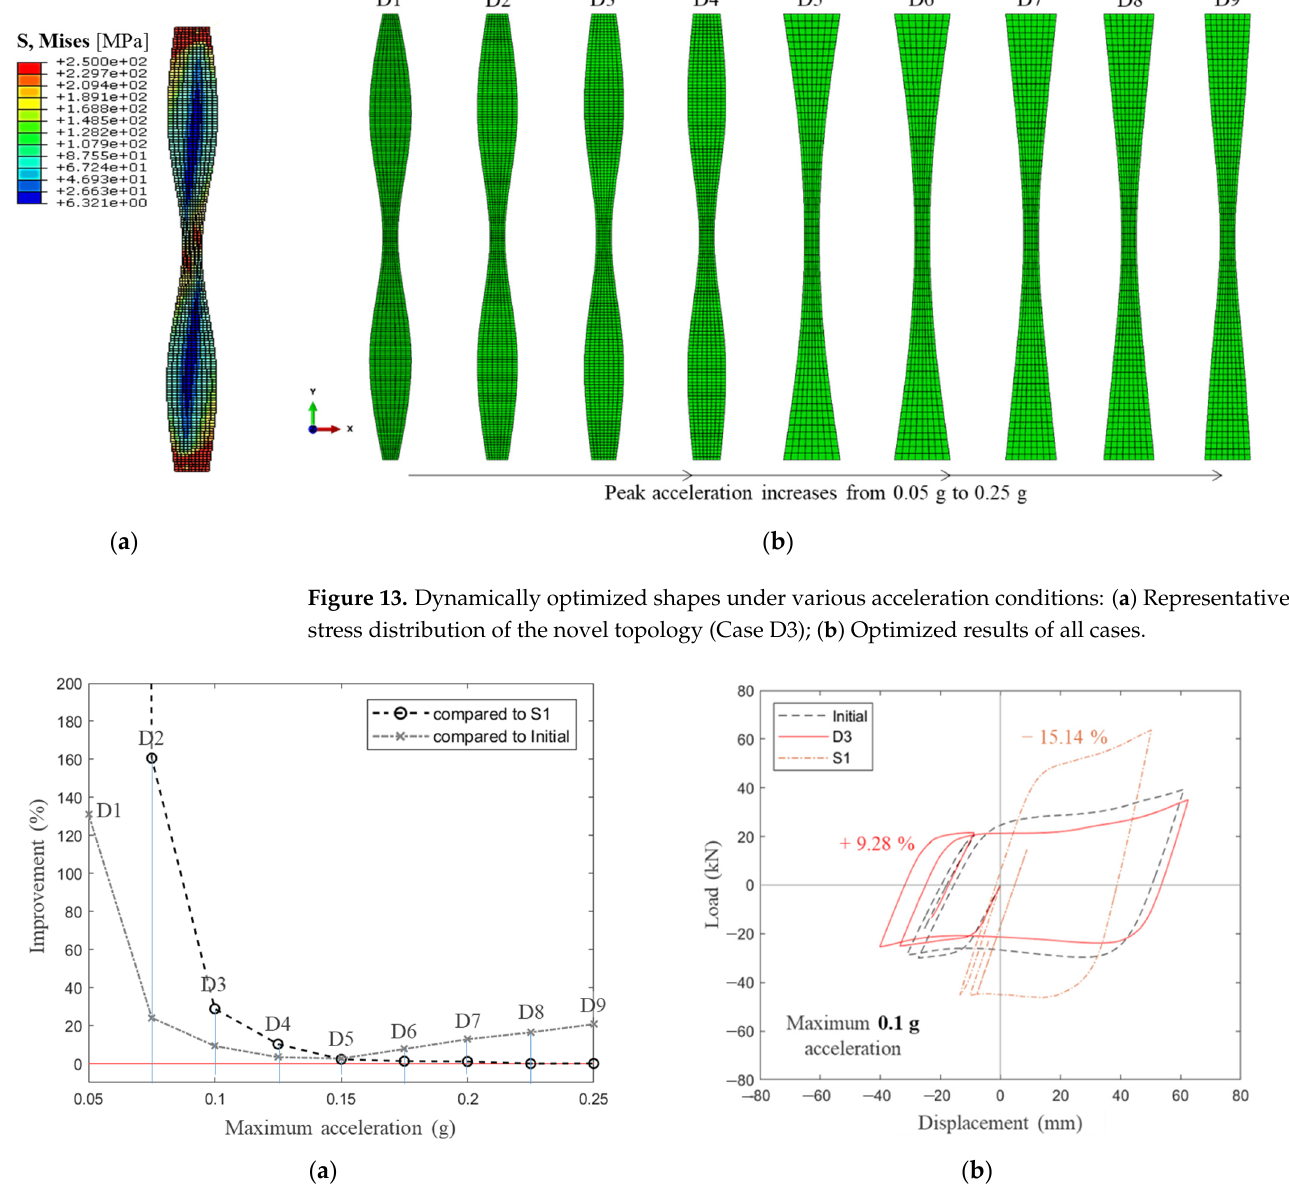
Figure 14. The energy dissipation of the dynamically optimized dampers: ( a ) Improvement of results; ( b ) Hysteresis loops of S1 and D3. Table 3. Shape variable values, energy dissipation, and improvement of each optimized model with a fixed thickness.